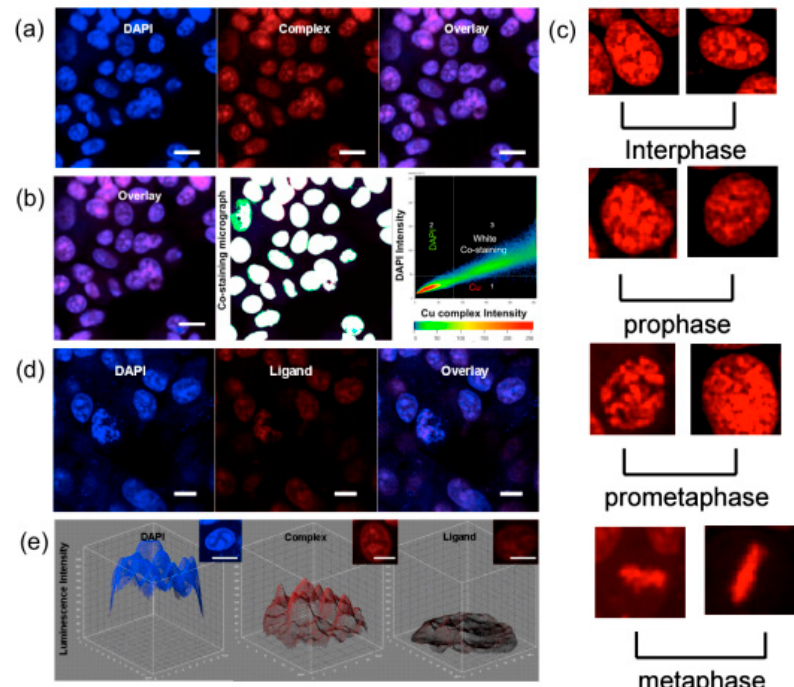
Figure 27. 2PFM of MCF-7 at: ( a ) Containing Cu 4 I 4 L 4 ( 99 ) (mid red) with DAPI (left blue) and overlay image (right); ( b ) Co-localization micrograph profile prove that the co-staining region corresponding to the white colocalization part which is located in the nuclear section; ( c ) Cell chromosome through progression of m-phase shows cellular luminescence by uptake cluster; ( d ) Containing L (mid red) with DPAI (left blue) and overlay image; ( e ) 3D intensity profile of DAPI, Cu 4 I 4 L 4 ( 99 ) (200 µ M) and L (200 µ M) luminescence across a MCF-7 single cell after incubation for 2 h. (All scale bars represent 10 µ M.)